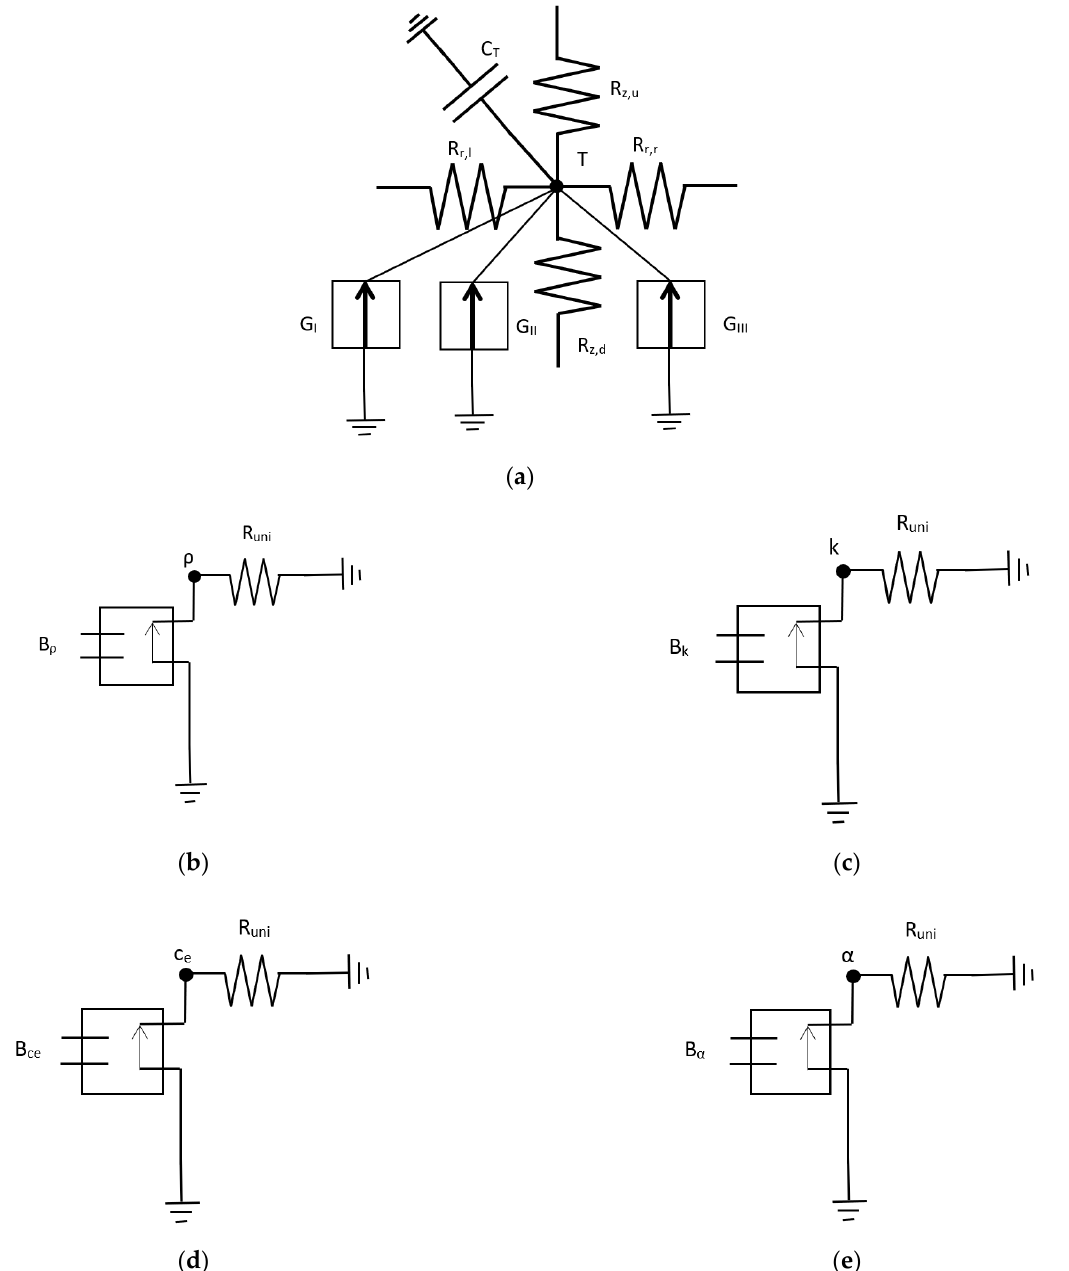
Figure 3. Network model of a volume element. ( a ) Temperature, ( b ) Density, ( c ) Thermal conductivity, ( d ) Speci fi c heat capacity, and ( e ) Thermal di ff usivity.